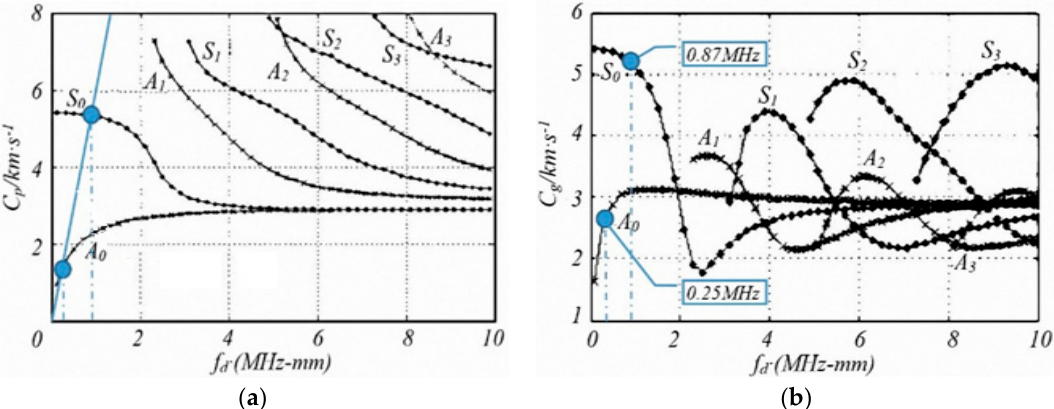
Figure 11. The frequency dispersion curve of a Lamb wave and the corresponding parameters: ( a ) Phased velocity; ( b ) Group velocity. ( a ) Phased velocity; ( b ) Group velocity.